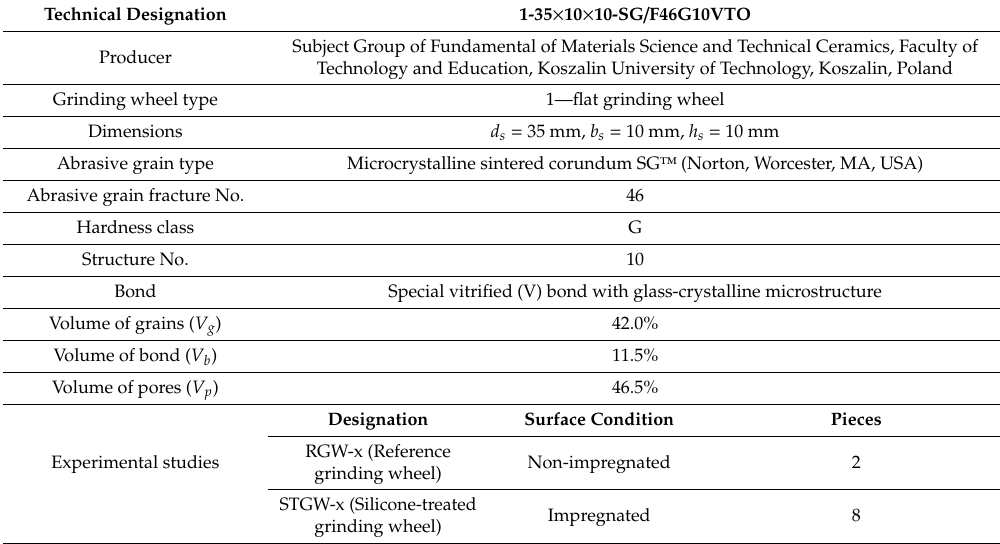
Table 2. General characteristics of the grinding wheels used in the experimental studies.